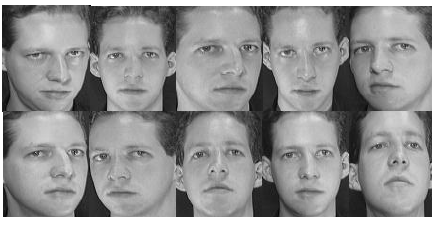
Figure 1. Samples of one subject from ORL database.